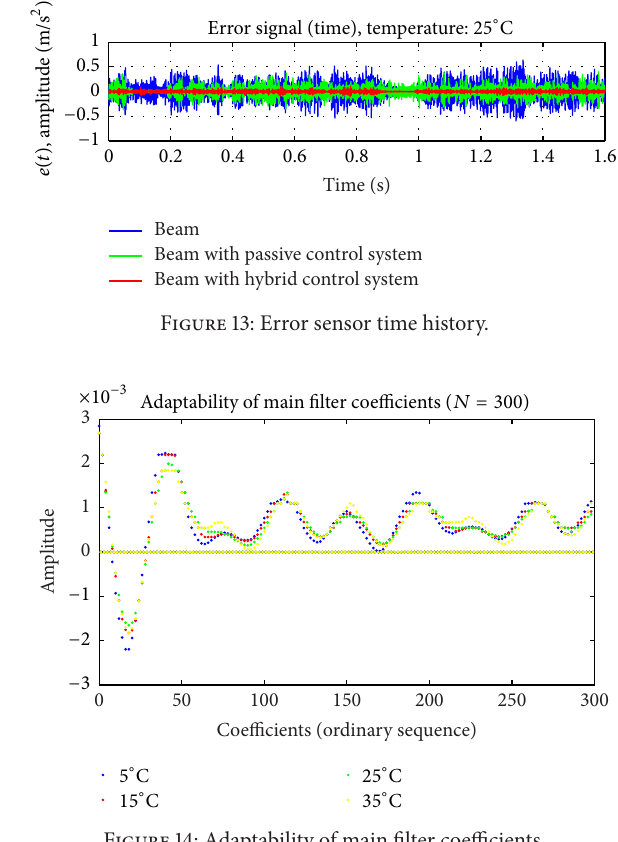
Figure 14: Adaptability of main filter